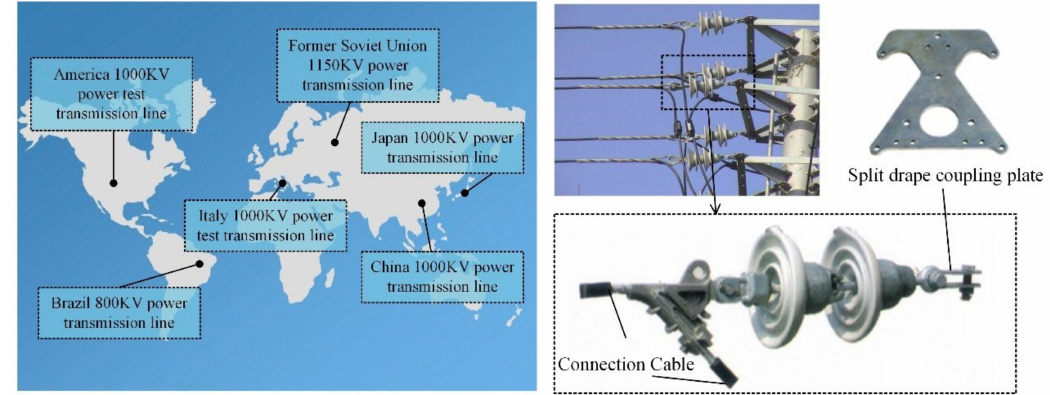
Figure 5. Schematic diagram of split drape coupling plates on a transmission line.